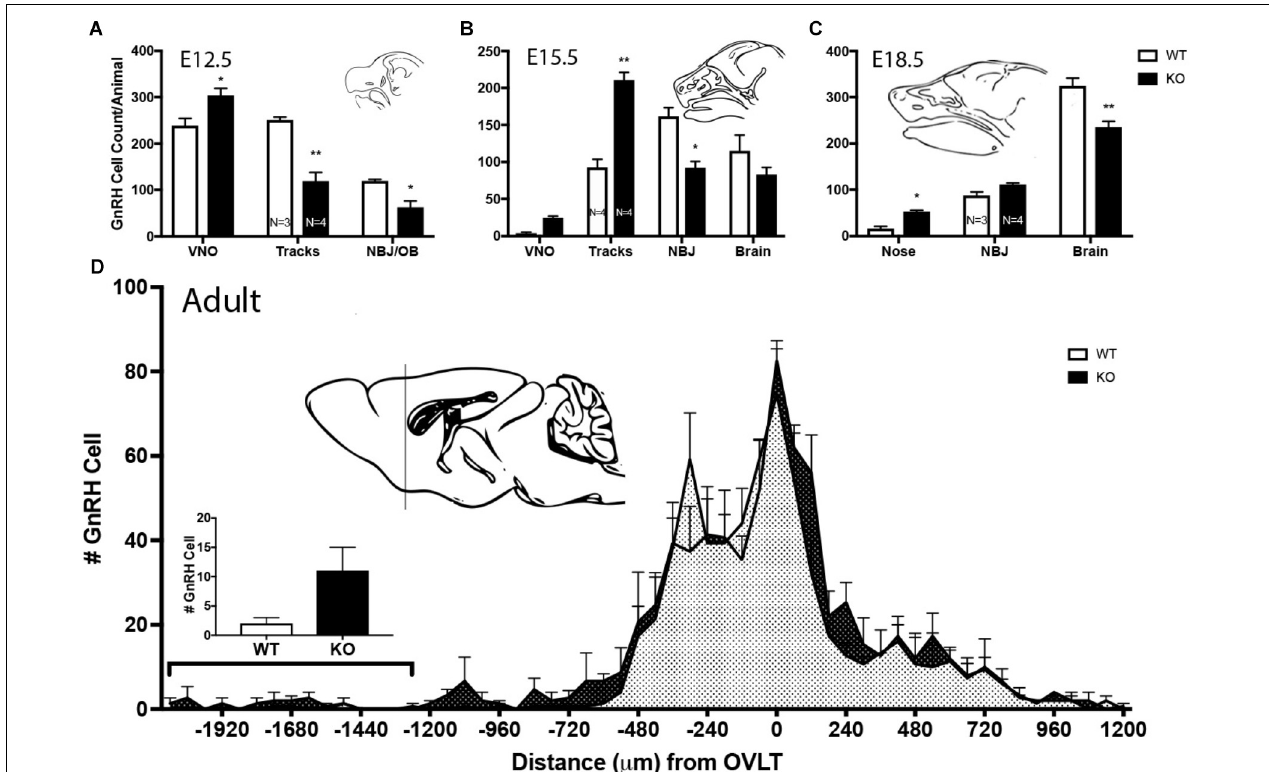
FIGURE 8 | Lack of GPR37 delays GnRH cell migration. (A–C) Distribution of GnRH cells at indicated embryonic ages. Cell location in embryos was classified depending of age; 3 regions at E12.5 [vomeronasal organ (VNO), migratory tracts, and nasal forebrain junction (NFJ)/olfactory bulb (OB)], 4 regions at E15.5 (VNO, tracks, NFJ, and Brain), and 3 regions at E18.5 (Nose, NFJ and Brain). At all three embryonic ages, there was a significant area × genotype interaction ( p < 0.0001, Two-way ANOVA), indicating the two genotypes behaved differently. Post hoc analysis (Sidak’ multiple comparison test, ∗ p < 0.05, ∗∗ p < 0.001) revealed a general trend across ages, with the KO mice having more GnRH cells in the nasal regions (VNO, Tracks, and Nose) and less cells in the brain compared to WT littermates. (D) In the adult brain, GnRH cells were mapped relative to the OVLT (negative numbers are toward the olfactory bulbs). KO animals have more GnRH cells in anterior regions. Histogram indicates number of GnRH cells from − 1200 (line of schematic on sagittal brain section) to − 1920. GnRH cells remained more rostral in the KO as compared to the WT (KS Test, p = 0.027; N = 3 for both groups).